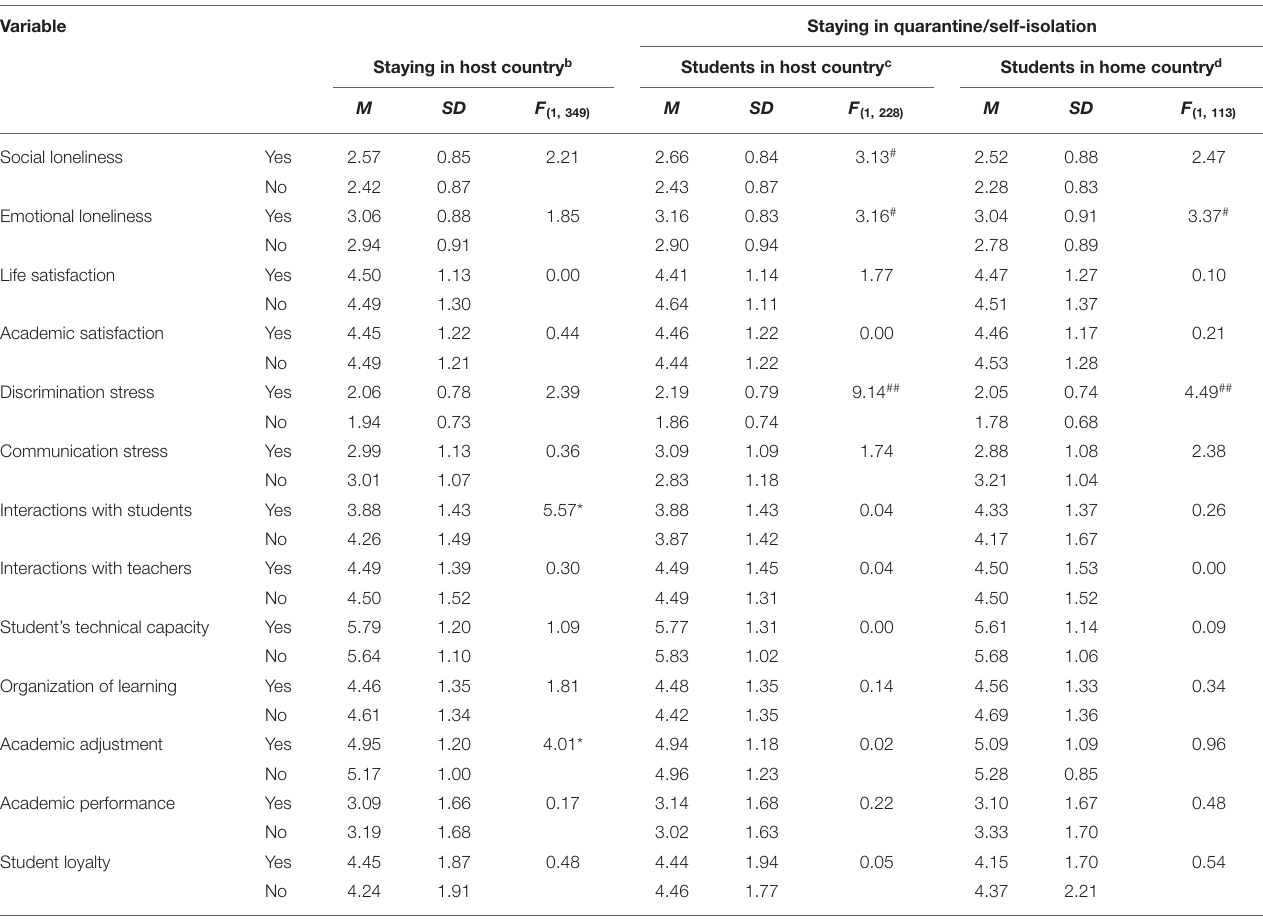
TABLE 3 | The effects of staying in the host ( N = 236) vs. home ( N = 121) country and staying vs. not staying in quarantine/self-isolation on international students’ well-being and academic experience a .